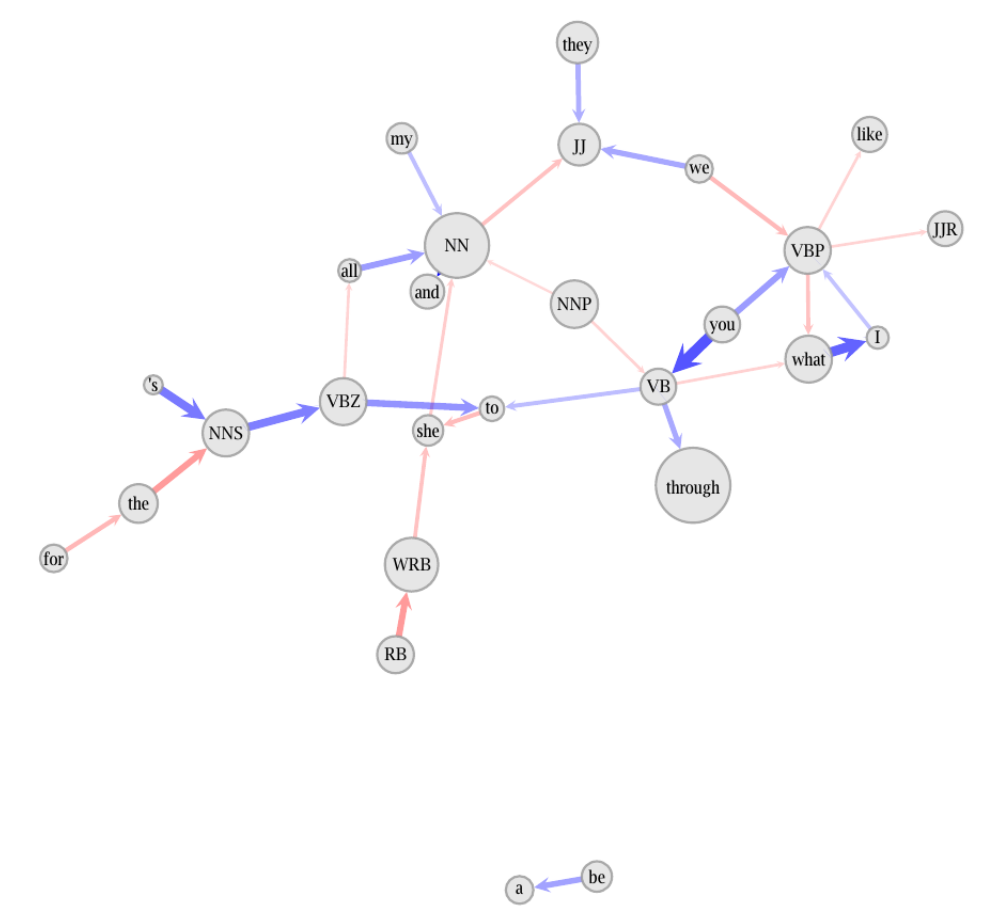
Figure 4. Comparative bigram graph for Bloom’s speech and thoughts. Blue arrows indicate over- representation in speech, red arrows indicate over-representation in